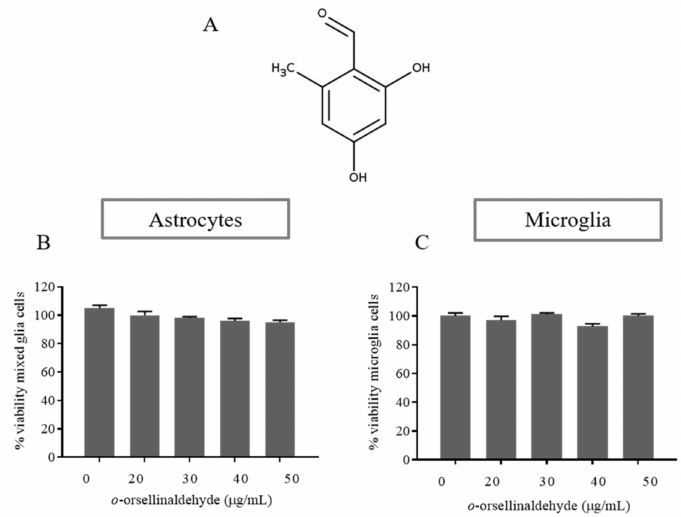
Figure 1. Effect of o -orsellinaldehyde on the viability of astrocytes and microglia cells. ( A ) Chemical structure of o -orsellinaldehyde. ( B ) MTT results of astrocytes treated with increasing concentrations of o -orsellinaldehyde (20–50 µ g/mL) for 24 h. ( C ) MTT results of microglia treated with increasing concentrations of o -orsellinaldehyde (20–50 µ g/mL) for 24 h. Results are shown as the mean ± SD of three independent experiments. Absence of symbols denotes no statistically significant differences.